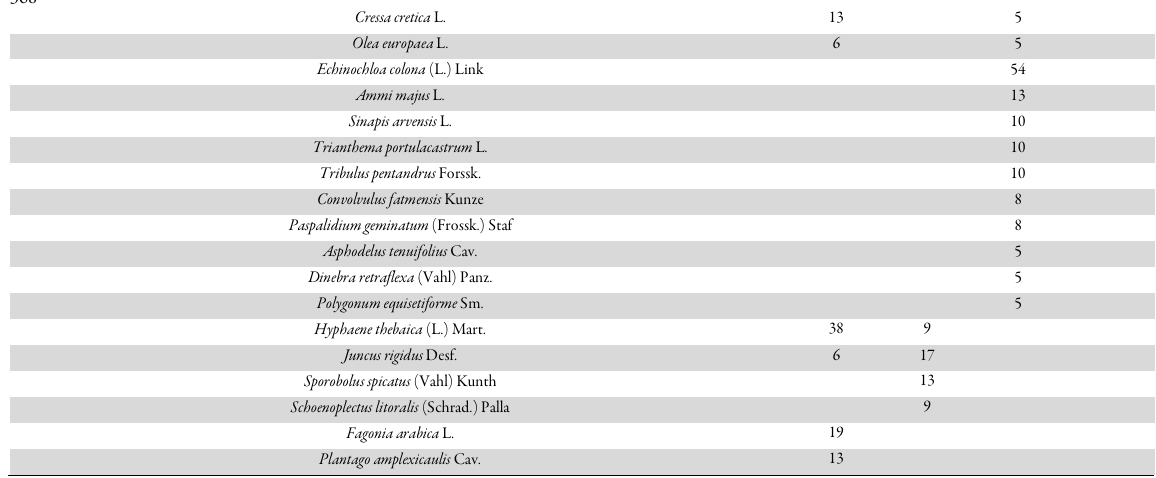
Table 2. Mean values, standard deviations and ANOVA values of the soil variables in the vegetation groups (A-D) of the study area (**= p < 0.01, * = p < 0.05) Soil variables